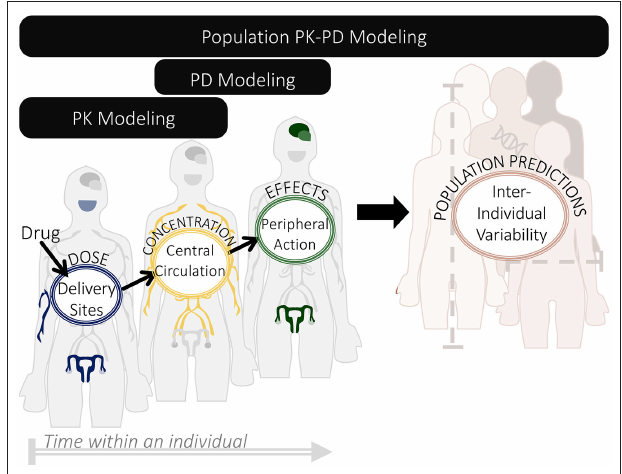
FIGURE 3 | Relationship between pharmacokinetic (PK), pharmacodynamic (PD), and population PK-PD modeling. These three modeling modalities can be used to make predictions about treatment from drug dosing to resulting effects, on an individual and population